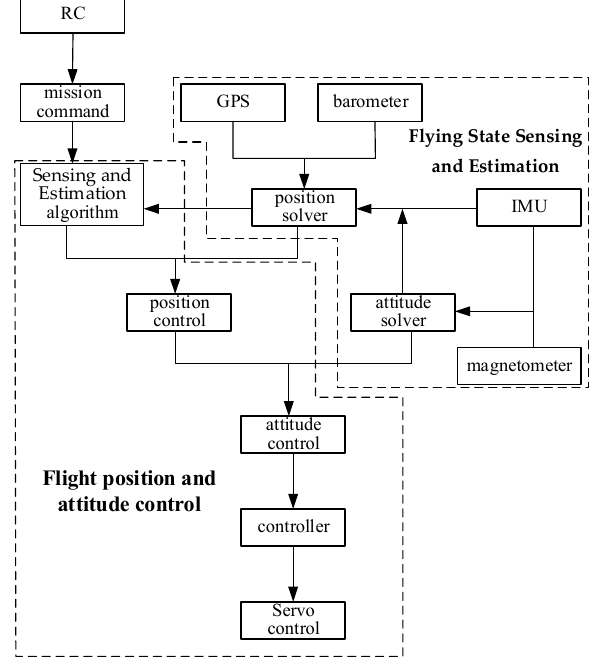
Figure 3. Functional block diagram of flying state sensing and estimation.